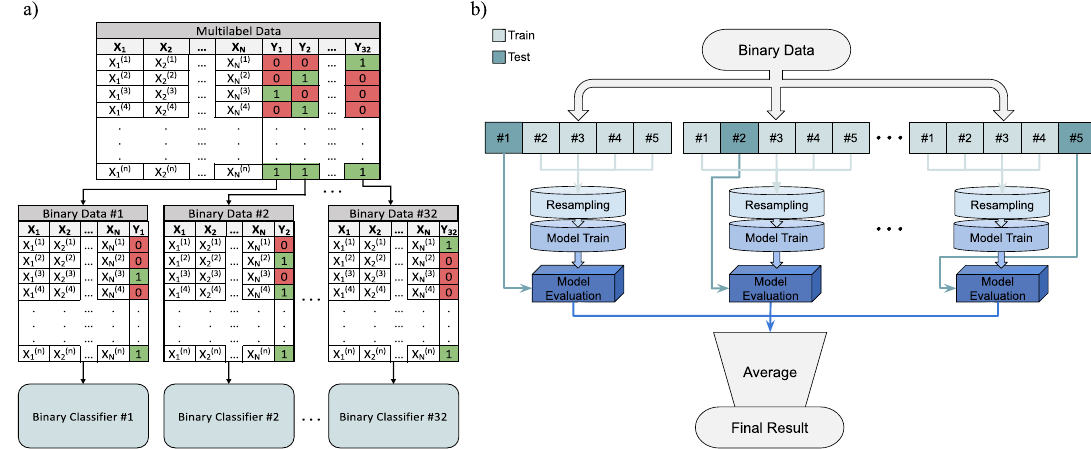
Figure 3. Classifier development procedure. ( a ) Multi-label data transformation to the binary relevance format. The first point group ( Y 1 ), is taken and fed to the binary classifier algorithm. The next binary data Y 2 is processed using the same procedure till the last binary data Y 32 . If the point group cell is 0, the chemical formula at that row does not exist with this symmetry and vice versa. The configuration of each point group 0 or 1 varies among the considered material space for training; and ( b ) The implemented 5-fold cross validation approach for each binary classification problem. The testing data set varies from one fold to another. After that, the training data set is resampled and subsequently trained for each fold. Then, the training model is quantified using the unseen testing data set. Finally, the evaluation metrics of the five folds are averaged to obtain the final versus-all binary learning tasks which are independent, one for each point group (class label). To apply binary relevance scheme as depicted in Fig. 3a, the entries with the same chemical formula are merged to allow for independent binary classification. We end up with 181, 054 unique chemical formulae. However, this binary relevance maneuver, from a single multi-label classification problem into 32 binary clas- sification problems, makes the data for each binary classifier hugely skewed toward the false class. In general, the results of imbalanced data are biased toward the majority class. Therefore, the transformation from imbalanced to balanced data is essential, especially for the extremely low count classes. In this work, the Synthetic Minority Over-sampling TEchnique (SMOTE), which was proposed by Chawla et al. 57 , is used to equalize the counts of the two binary classes of the training data of each classifier. Figure 3b illustrates the developed algorithm, where a 5-fold cross-validation is used to better assess the validity of each of the 32 binary classifiers. The implemented folding strategy is stratified, that is, the true classes are equally distributed to each fold. Many classification methods are used and the majority of them result in excellent and comparable accuracies. In all cases, the default hyperparameters were kept as is without tuning to avoid undermining the fidelity and validity of the obtained scores. To evaluate the accuracy of the developed point group classifier, the Balanced Accuracy (BA) and the unit normalized MCC (UM) 45 are utilized based on the genuine test sets (no synthetic data are used for testing). For imbalanced data as in our case, the standard accuracy and F-measure (F 1 ) profoundly exaggerate the optimistic statistical measures and produce inflated results. More details and comparisons of classification metrics are